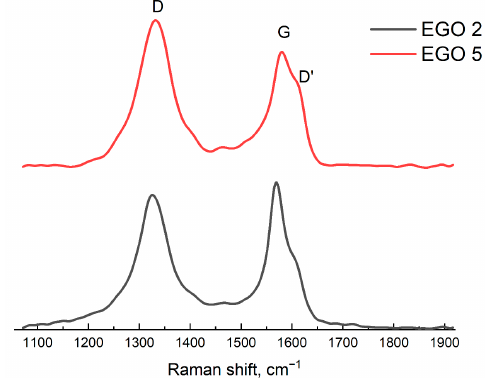
Figure 5. Raman spectra for samples: EGO 2 (black line), two-step synthesized samples of EGO with a separated cathode–anode compartment with additional current treatment and a platinum rod as an anode (procedure 3); EGO 5 (red line), one-step synthesized samples of EGO with a separated cathode–anode compartment without further current treatment (procedure 5) .